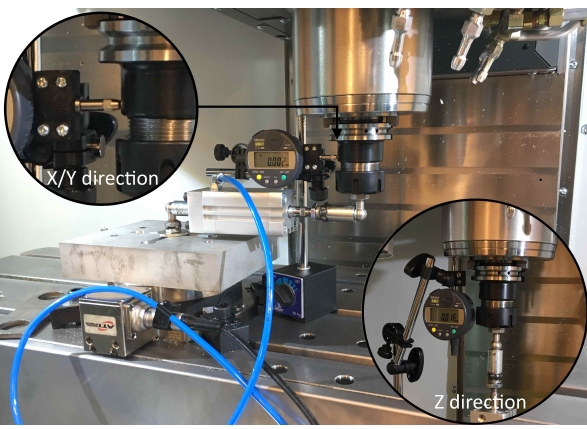
Figure 7: 3-axis CNC, test 1.2: Test setup using Mitu- toyo 543-251B digital dial